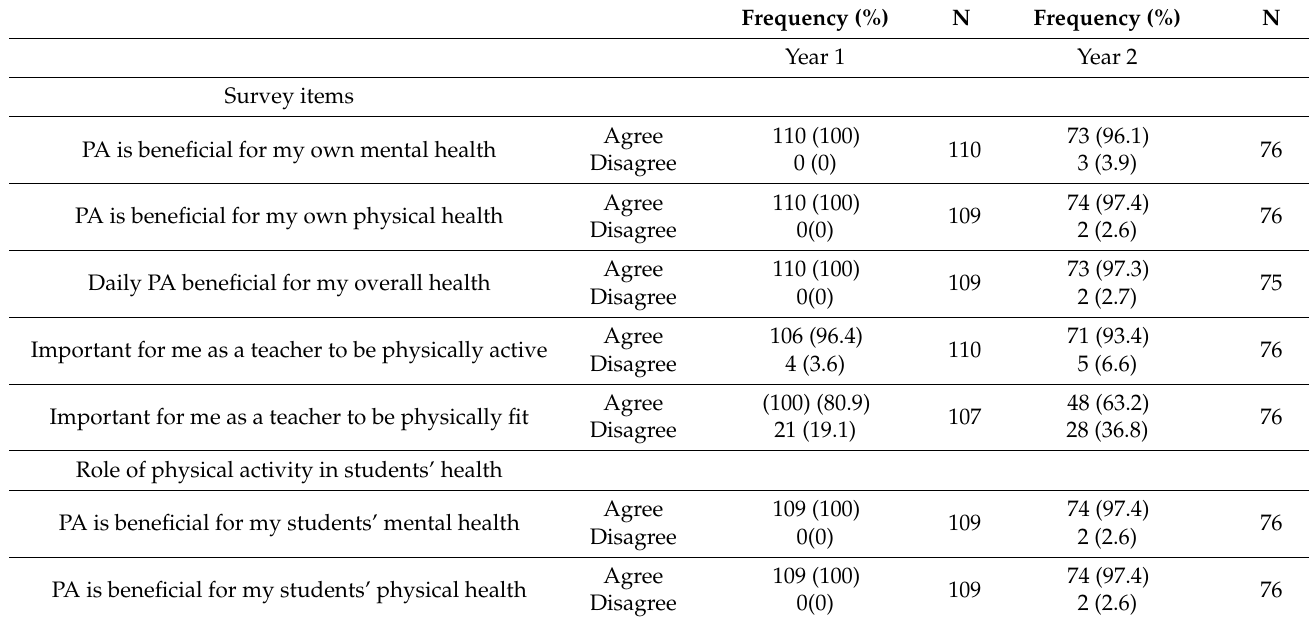
Table 1. Pre-service teachers’ perceptions of physical activity as it relates to their own and their students’